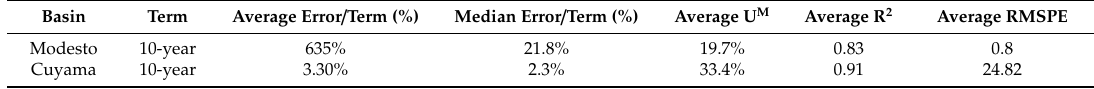
Figure 7. Modesto Basin 5-year groundwater system simulation. Table 8. Results of the 10-year